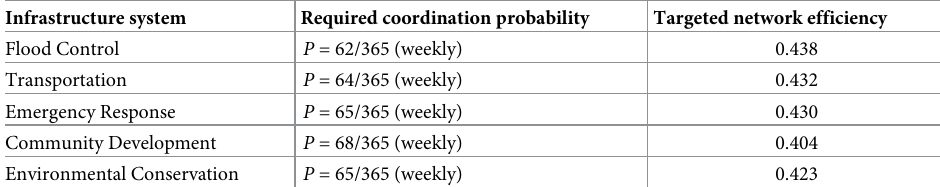
Table 8. Required coordination probability within infrastructure systems.